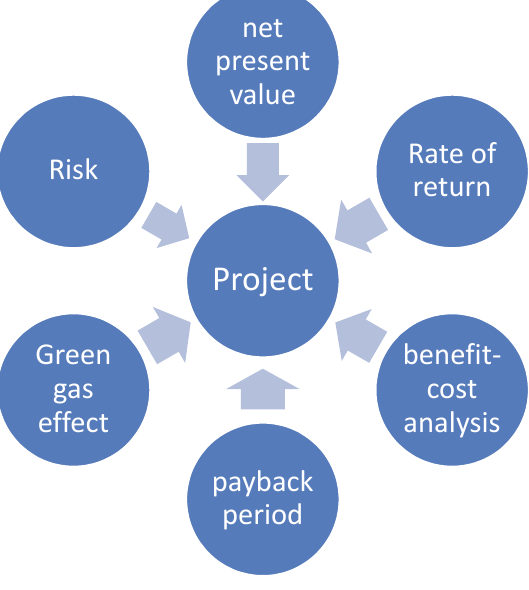
Fig. 1. The structure of the proposed